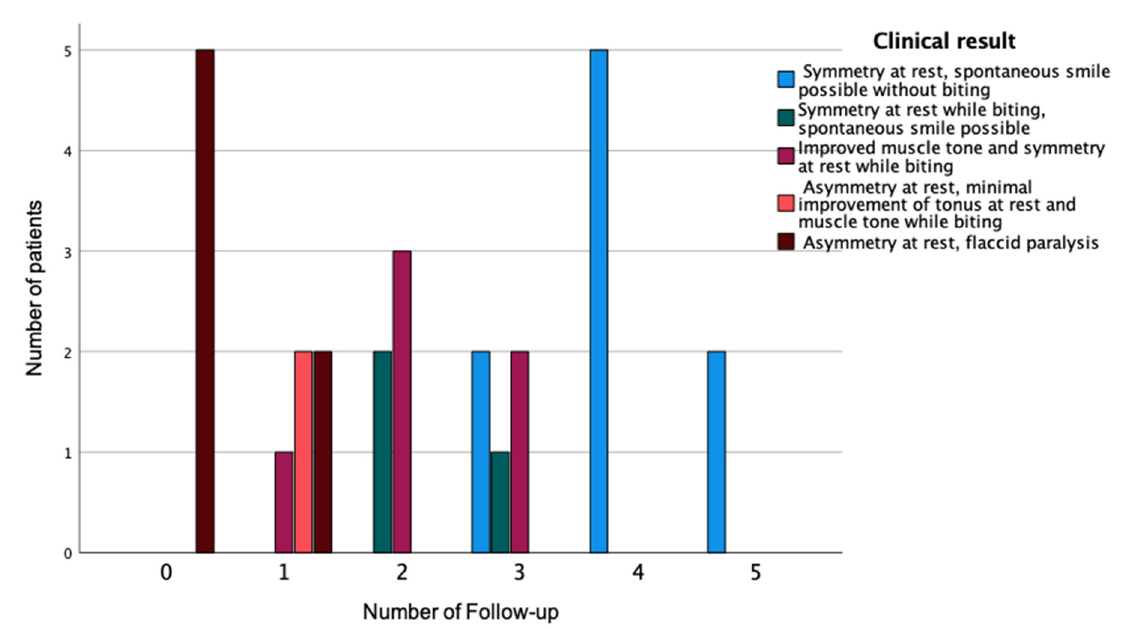
Figure 3. Functional outcome at the first to fifth follow-up visit. 0 = preoperative state, 1–5 = number of the follow-up visit.